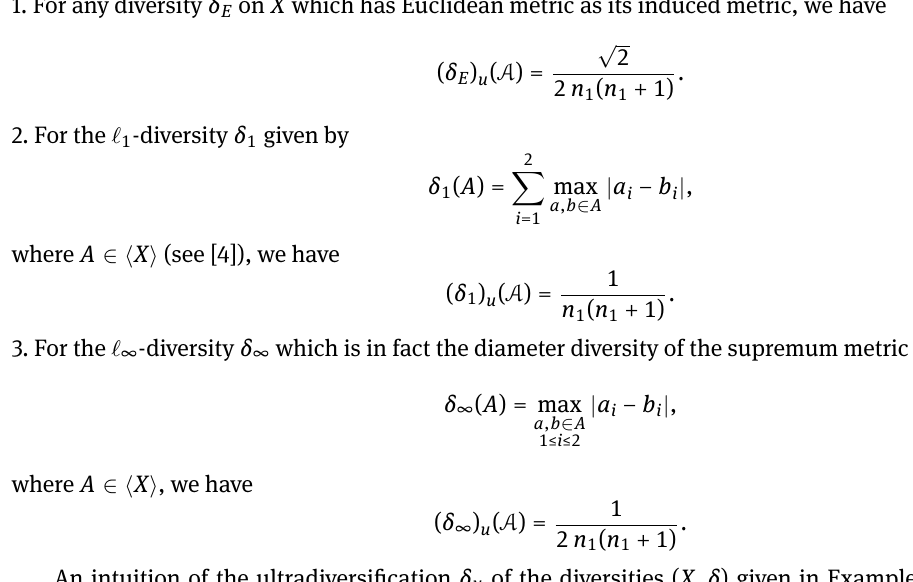
It is clear that every ultradiversity is an ultradiversification of itself. In addition, it is not hard to see that any two diversities on a set X with equivalent induced metrics can have the same uX . To illustrate it more, let us see the diversities given in the following